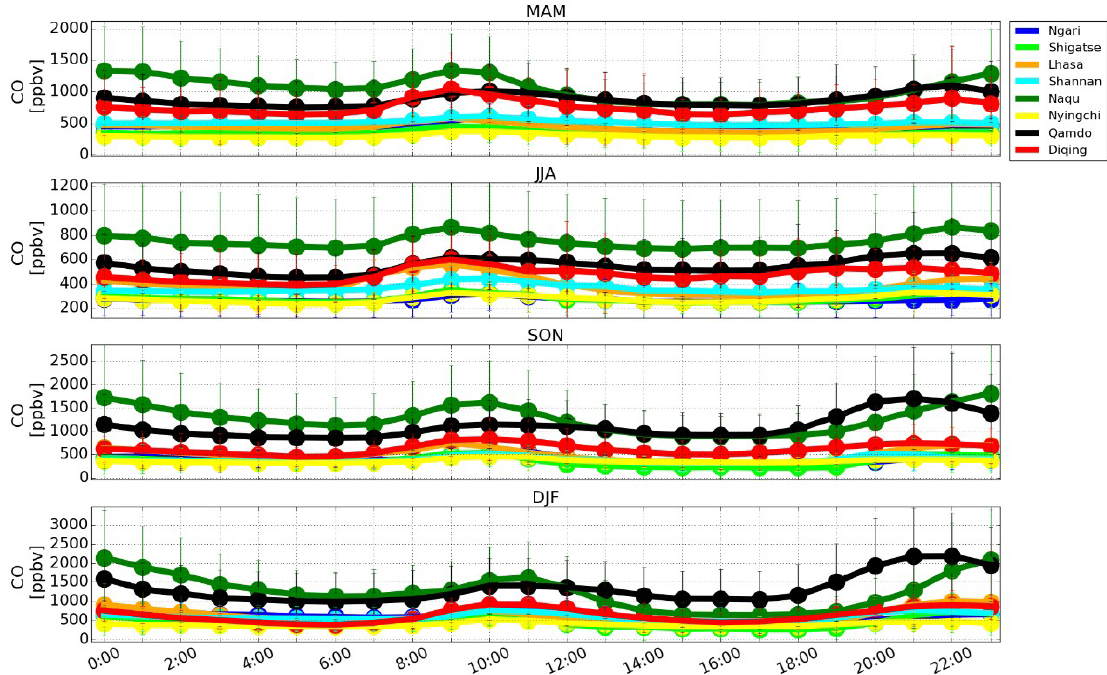
Figure 2. Diurnal cycles (local time, LT) of surface CO VMR in four seasons over the HTP. The vertical error bar is 1 σ standard variation within that hour. Results are based on CO time series from 2015 to 2020 provided by the CNEMC network.